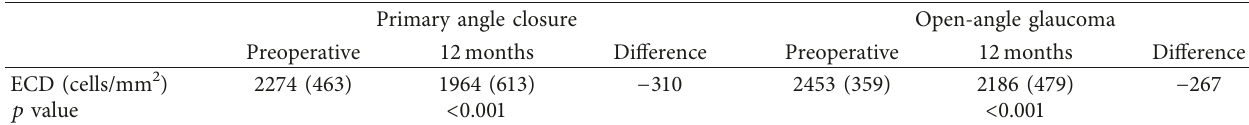
Table 4: Comparison of endothelial cell density change in primary angle closure and in open-angle